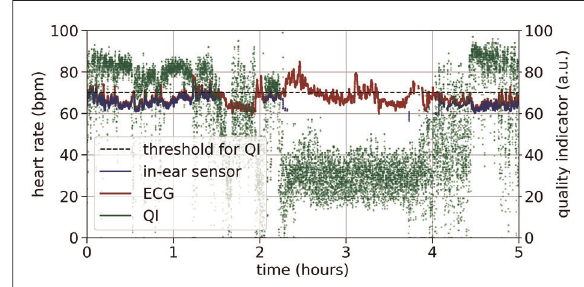
FIGURE 4 Example of a critical quality heart rate recording (bpm) over fi ve hours by the ECG (red) and the in-ear sensor (blue). The signal quality indicator of the in-ear sensor (green) returns values below the quality threshold of 70 (indicated by the dashed line) for certain periods of